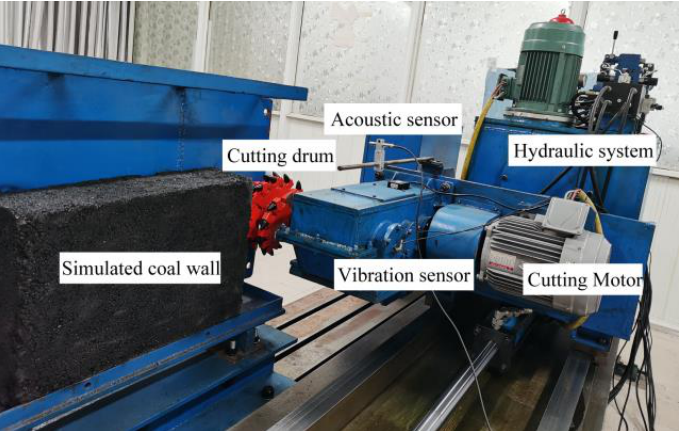
Figure 9. Shearer simulation cutting test system.